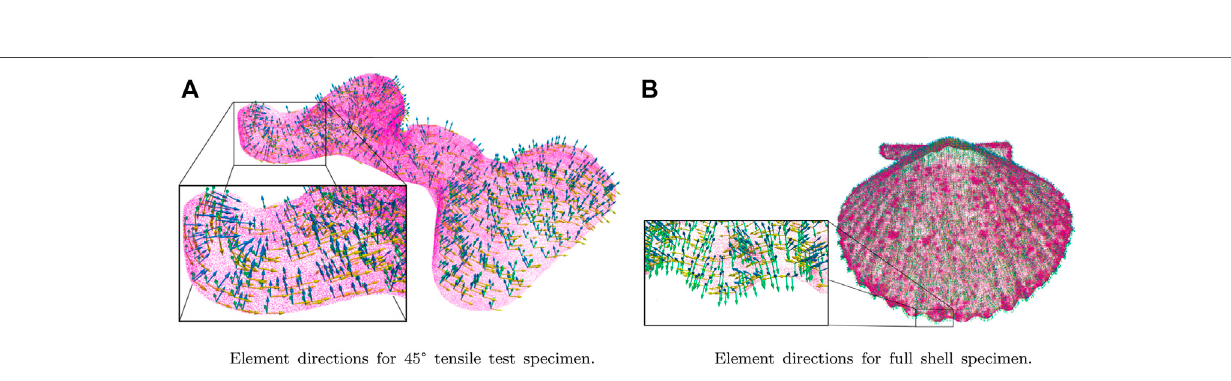
Frontiers in Bioengineering and Biotechnology |